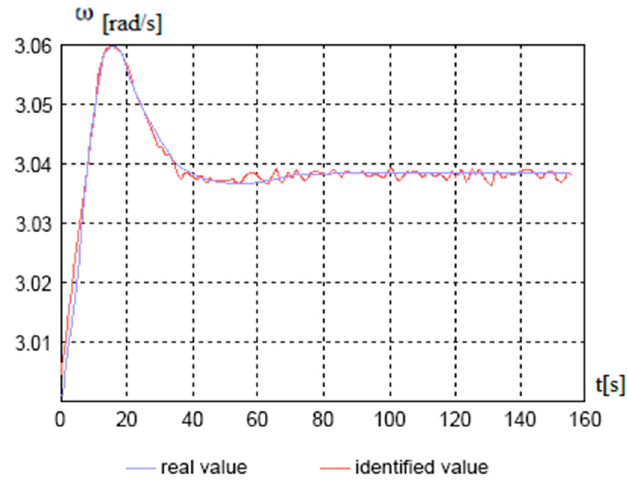
Figure 4. Estimation of the angular velocity of the vessel during circulation. Based on estimates of the speed and angular velocity of the vessel’s circulation, it is possible to calculate the functions in Equations (2) and (4).